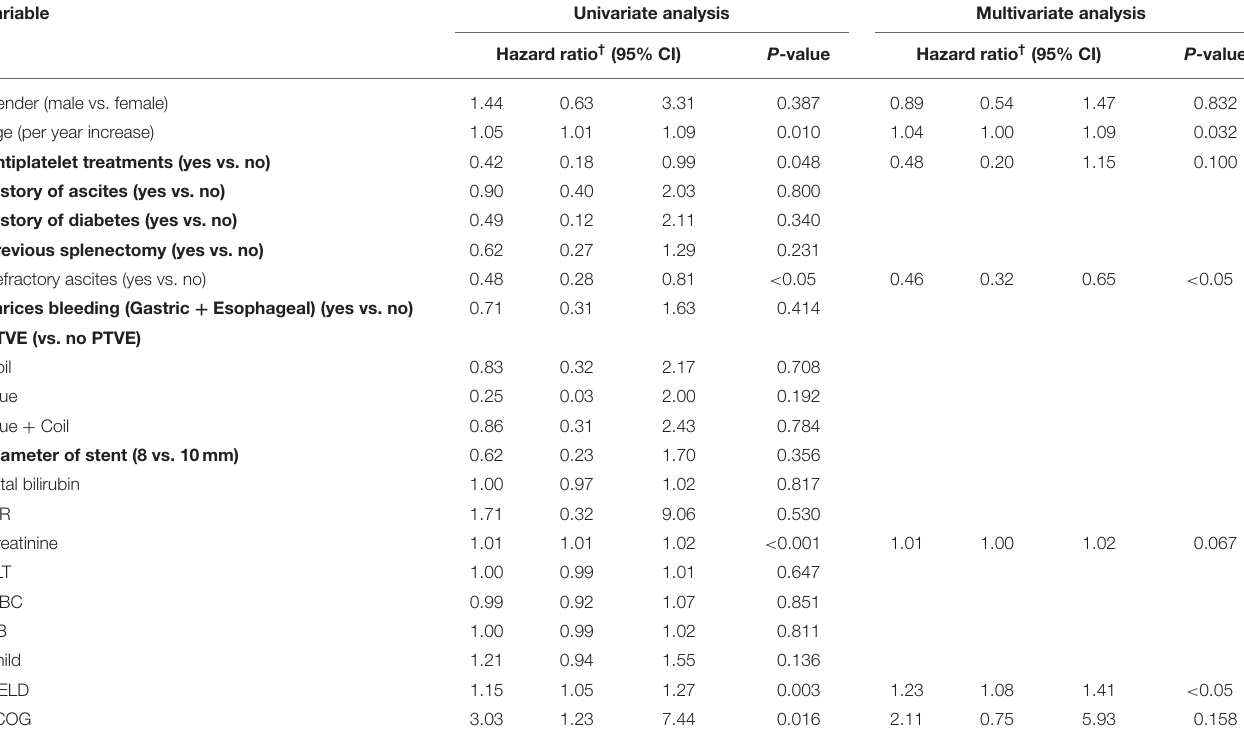
TABLE 3 | Factors associated with risk of mortality after Transjugular intrahepatic portosystemic